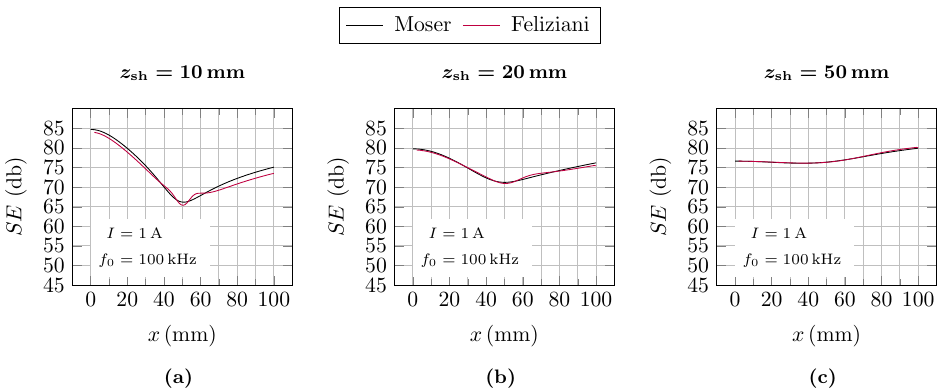
Figure 3. Comparison of the approaches of Moser [16] and Feliziani et al. [17] using the example of a copper plate ( t = 1 mm, σ Cu = 57 MS/m, µ r,Cu = 0.9999) with the system parameters R = 50 mm, I = 1 A and f = 100 kHz as given in [17]: Shielding effectiveness SE along the radial distance x at z = z sh + t depending on the distance between coil and shield ( a ) z sh = 10 mm, ( b ) z sh = 20 mm and ( c ) z sh = 50